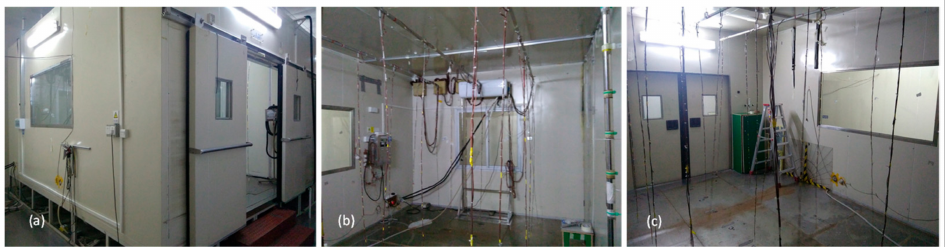
Figure 6. Pictures of the air-conditioned testing laboratory used in this study: ( a ) the appearance of the inner chamber; ( b ) the interior of inner chamber from the door side; ( c ) the interior of inner chamber from the window